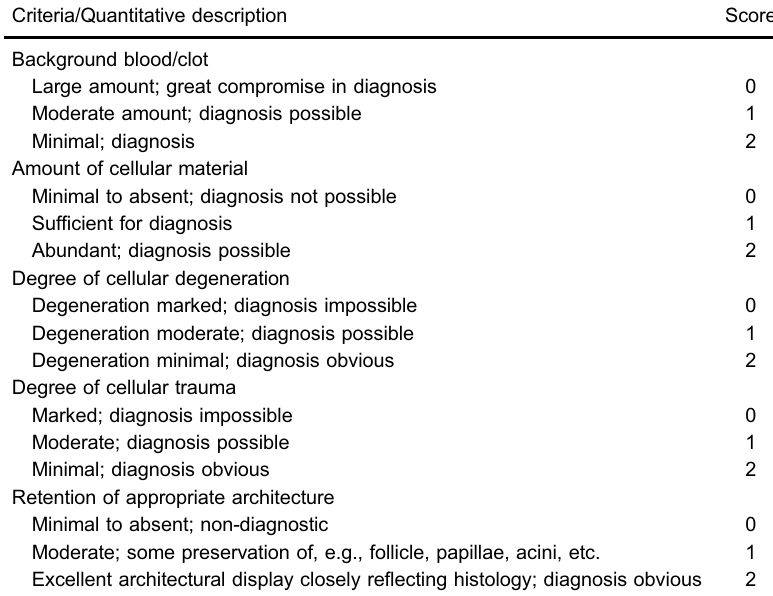
Table 1. Evaluation of pathological and diagnostic results.